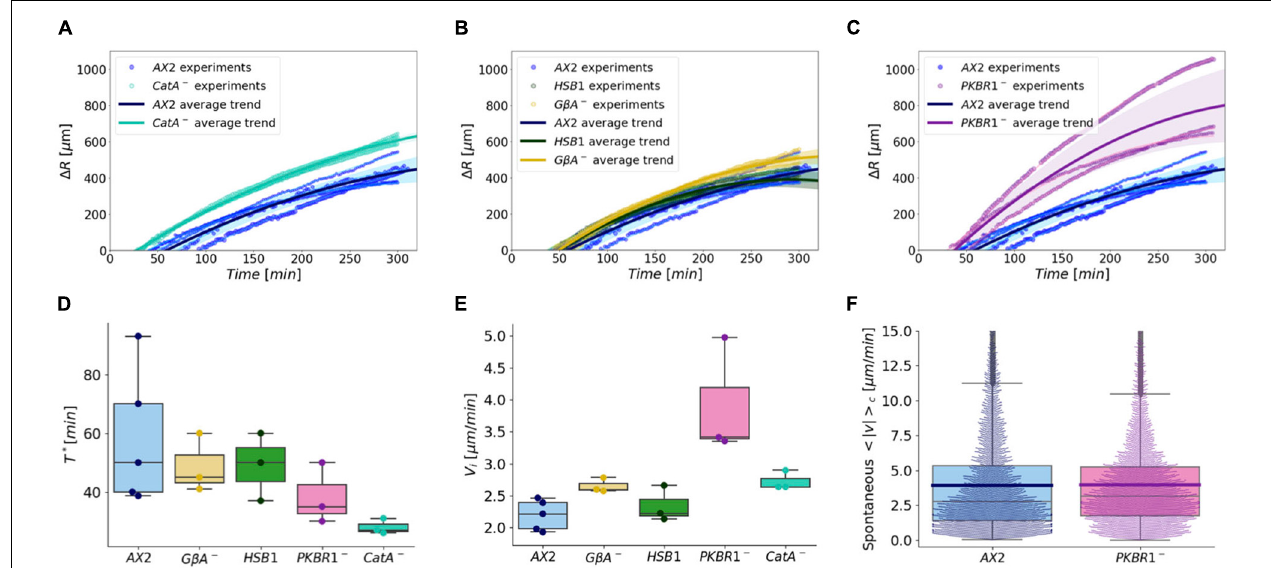
FIGURE 7 | Comparison between the migration of wild-type cells and various chemotaxis deficient mutants under growing conditions. (A–C) We report the time evolution of the corona displacement of independent experiments (colored bullets): different colors represent different Dictyostelium strains, whereas the size of the markers corresponds to distinct experiments. To group the corona displacement trends of the same genotype, we represented the mean value of all the experiments (continuous colored lines) and their standard deviation (colored shaded regions). Comparison of the ring dynamics (A) between WT and catA null mutants; (B) among WT, HSB1, and G β null mutants; (C) between WT and pkbR1 null mutant. Boxplots in panels (D,E) summarize, respectively, the estimated ring formation time T* (measured over at least three experiments for each cell type) and the ring initial propagation speed v i . (F) The spontaneous motility (measured as the average instantaneous speed) under not confined conditions for single cells of the WT and pkbR1 null strains (mean values are represented by the blue and purple horizontal lines).